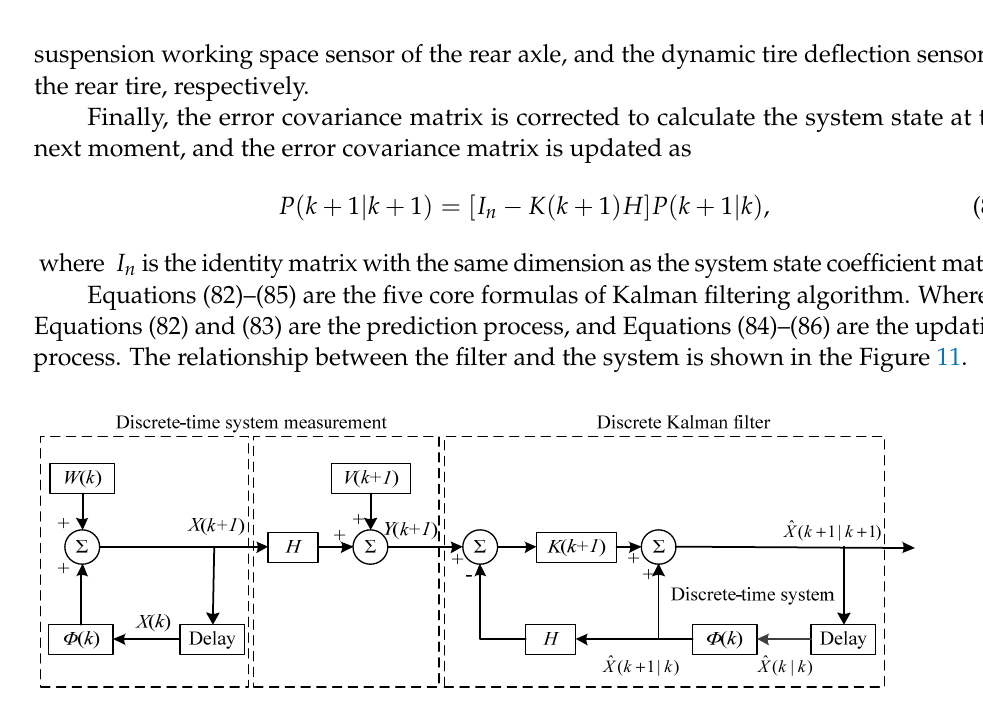
Figure 11. Block diagram of discrete Kalman filter.